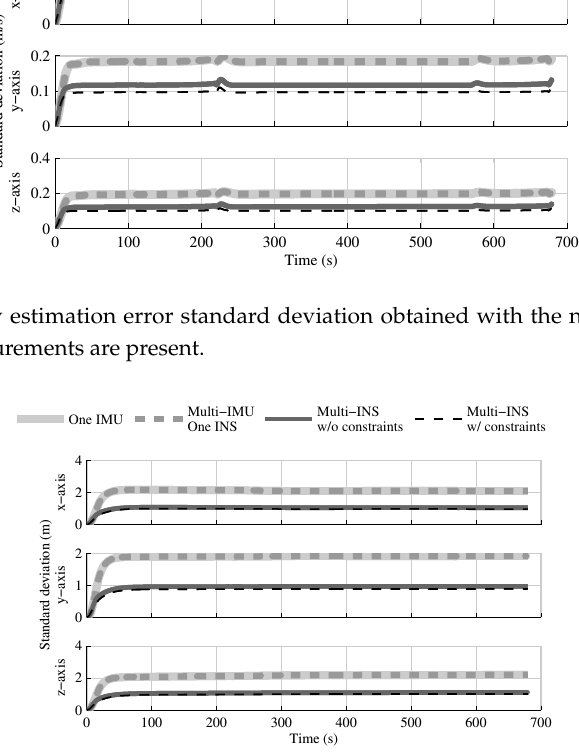
Figure 6. The position estimation error standard deviation obtained with the navigation solutions, when all sensor measurements are